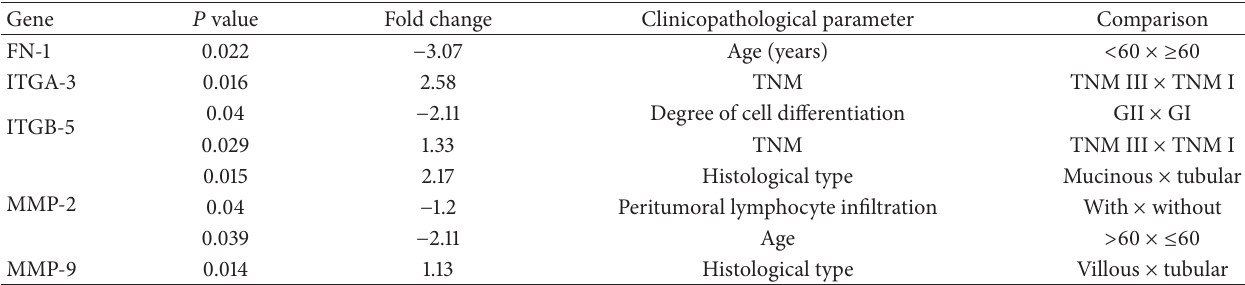
Histological type Villous ×